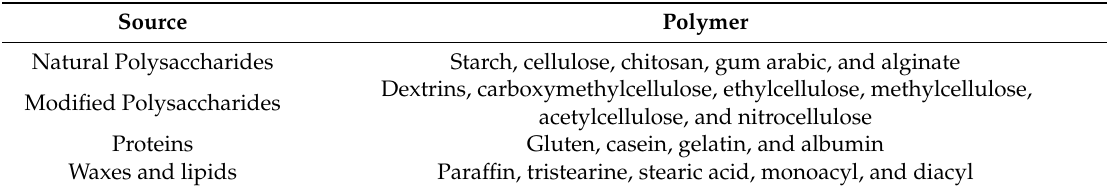
Table 1. Polymers used in microencapsulation